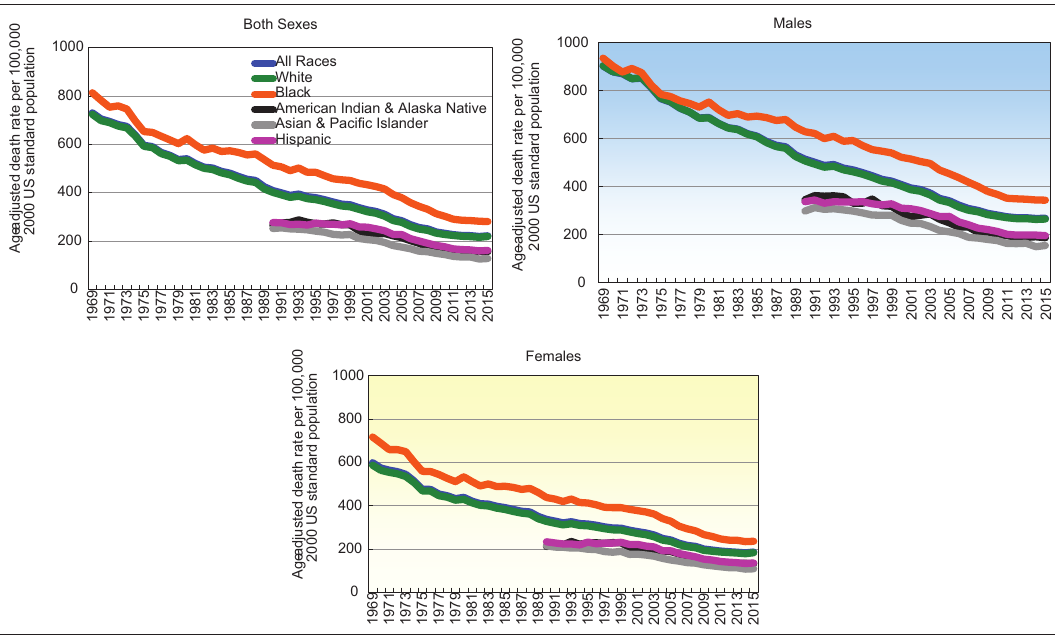
Figure 13. Trends in CVD Mortality by Race/Ethnicity and Sex, United States, 1969-2015 Source: Singh GK, Siahpush M, Azuine RE, Williams SD. Widening Socioeconomic and Racial Disparities in Cardiovas - cular Disease Mortality in the United States, 1969-2013. International Journal of MCH and AIDS. 2015; 3(2)106-118 (updated